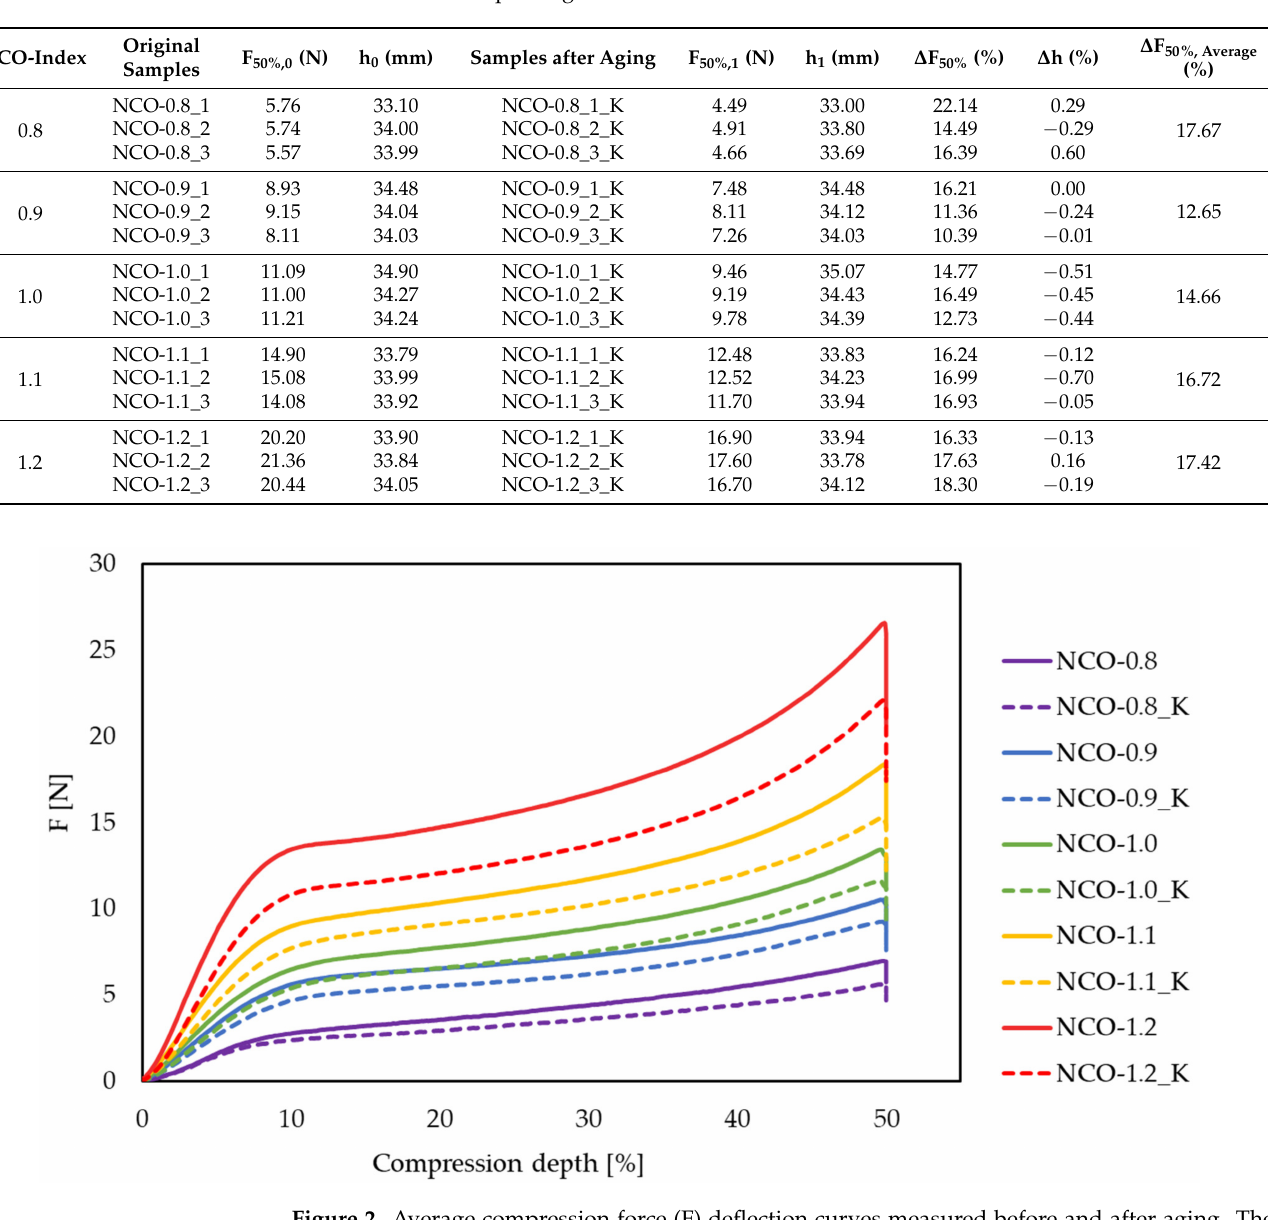
Table 1. Compression force deflection test results according to ASTM D3574 Test C. The first sample with 0.8 NCO-index is indicated as NCO-0.8_1 and NCO-0.8_1_K before and after dry heat aging, respectively. F 50%,0 is the force measured at 50% sample height compression depth before aging; F 50%,1 is the force measured at 50% sample height compression depth after aging; h 0 is the original sample height; h 1 is the sample height after aging; ∆ F 50% is the rate of force reduction; ∆ h is the reduction in the sample height.